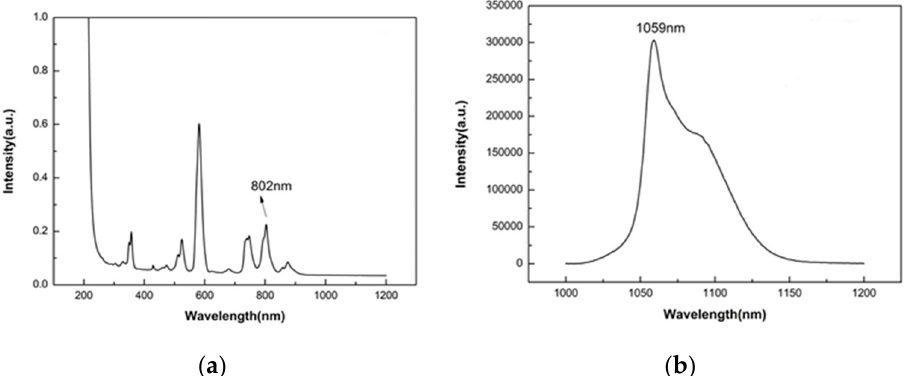
Figure 1. ( a ) Absorption spectrum and ( b ) fluorescence spectrum of NDSG with a doping concentration of 0.3 mol%. of 0.3